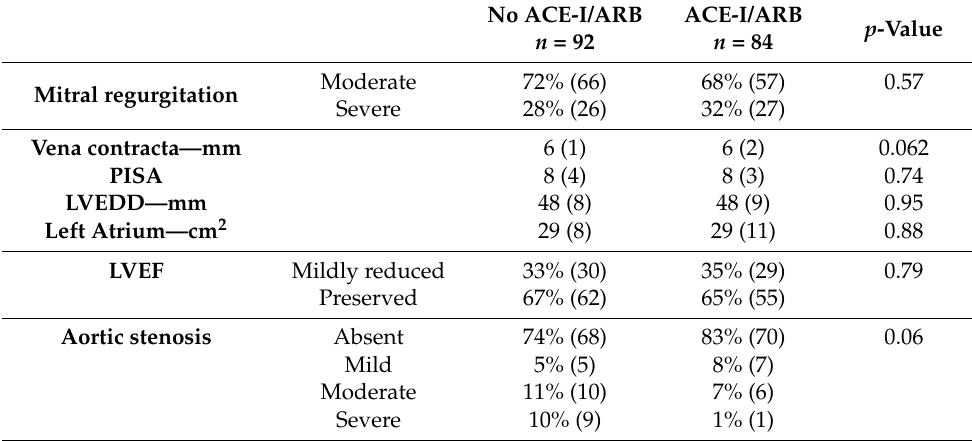
Table 2. Echocardiographic parameters at baseline. Continuous variables are given as means ± SD. Categorial variables are given as percentages and frequencies.